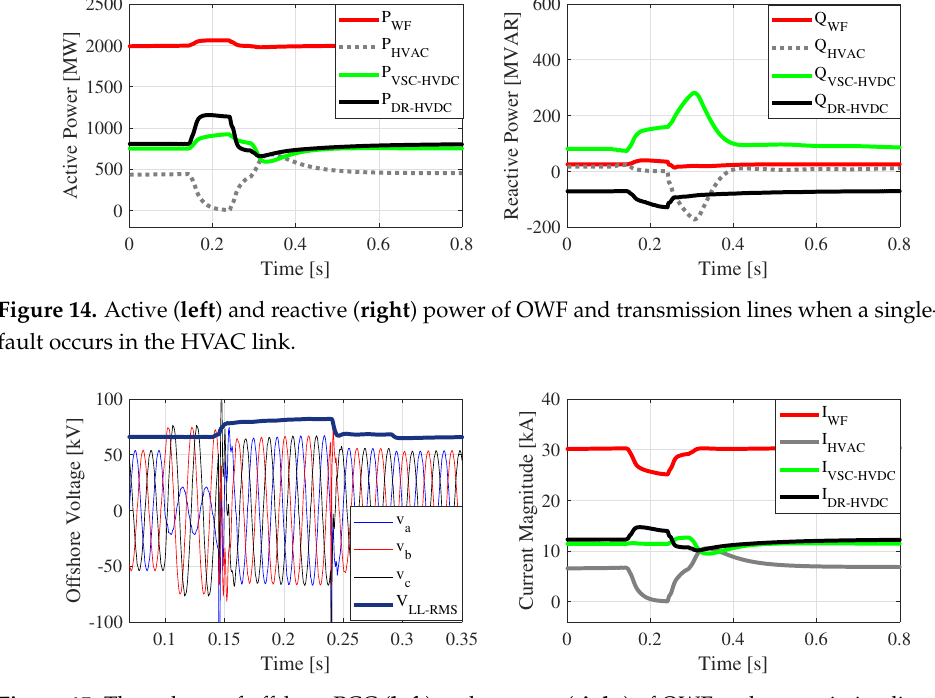
Figure 15. The voltage of offshore PCC ( left ) and currents ( right ) of OWF and transmission lines when a single-phase fault occurs in the HVAC link.